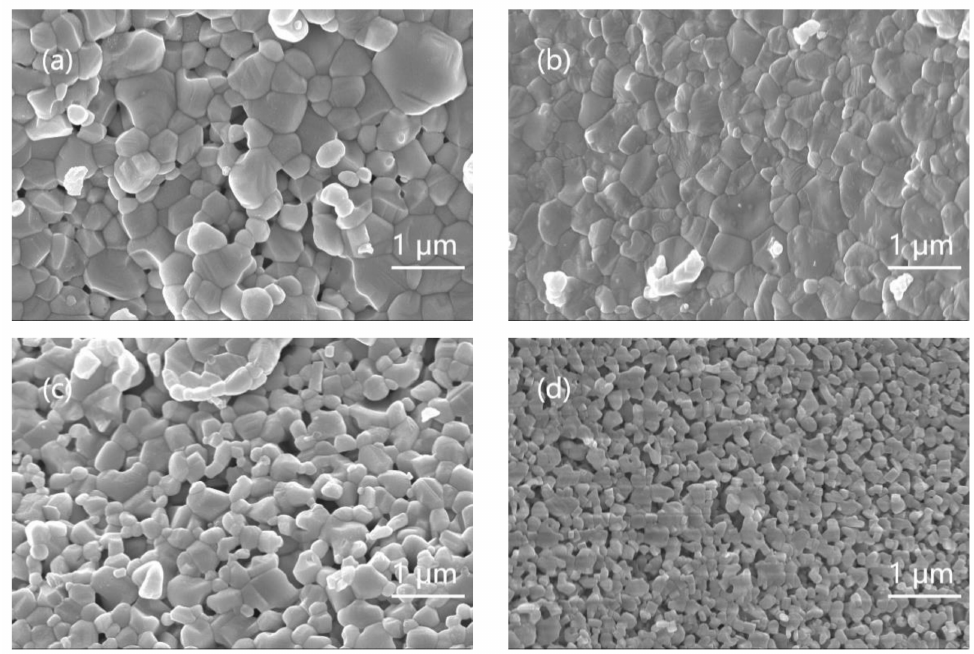
Figure 3. SEM test results of nanofillers and element-doped fillers. ( a ) Pure BFO nanofillers; ( b ) BL5FO nanofillers; ( c ) BFC3O nanofillers; ( d ) BL5FC3O